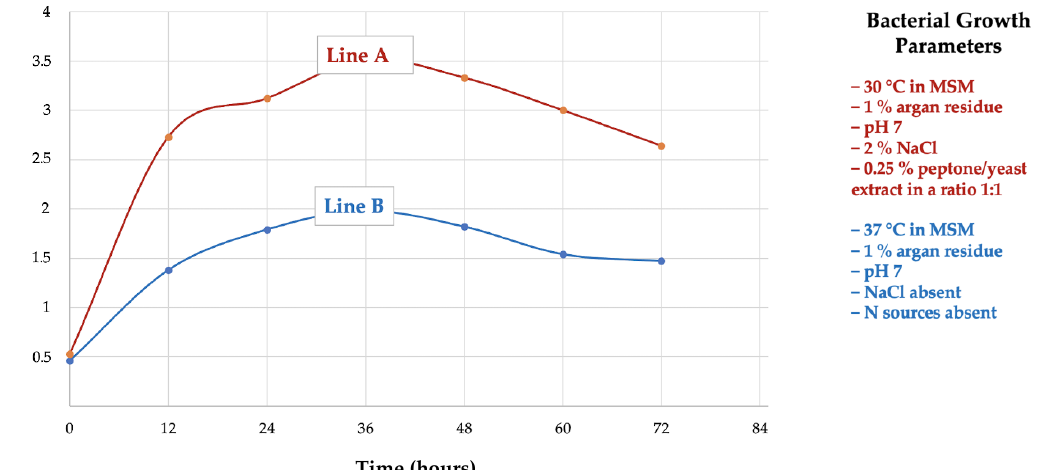
Figure 8. Bacterial growth curve of strain 1B; Line A shows the bacterial growth under selected optimal parameters, Line B shows the bacterial growth under unselected optimal parameters, and in the absence of NaCl and N sources.